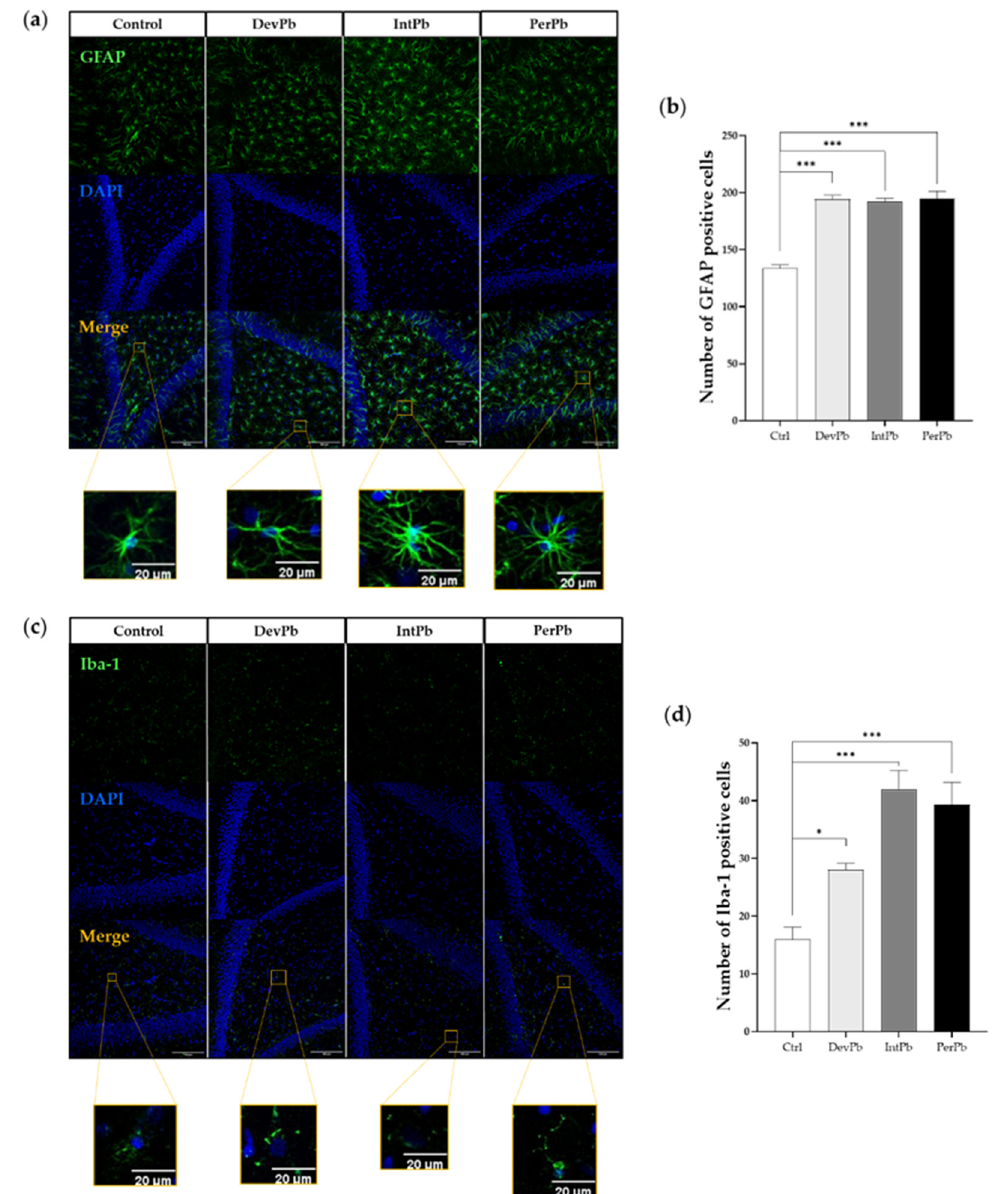
Figure 3. Neuroinflammation evaluation through astrocytic (GFAP) and microglial (Iba1) markers by immunohistochemistry: ( a ) Representative images of the GFAP (1:500)-stained astrocytes. ( b ) Histogram of GFAP-positive cells’ quantification. ( c ) Representative images of the Iba1 (1:250)- stained microglia. ( d ) Histogram of Iba1-positive cells quantification. Images were acquired on a confocal point scanning microscope, (Zeiss LSM 880 with Airyscan), with a 20× objective. The scale bar is 50 µm or 20 µm for stained images. Values are the mean ± SEM. The asterisks denote statisti- cally significant differences between groups; * p < 0.05; *** p < 0.001; one-way ANOVA, with multiple comparisons (Dunnett’s test); n = 4/group.